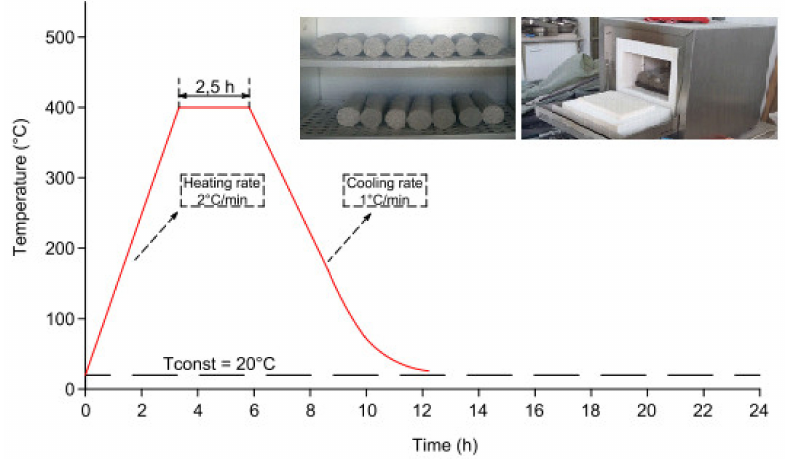
Figure 5. Heating conditions in the furnace; specimens in the dryer and furnace.